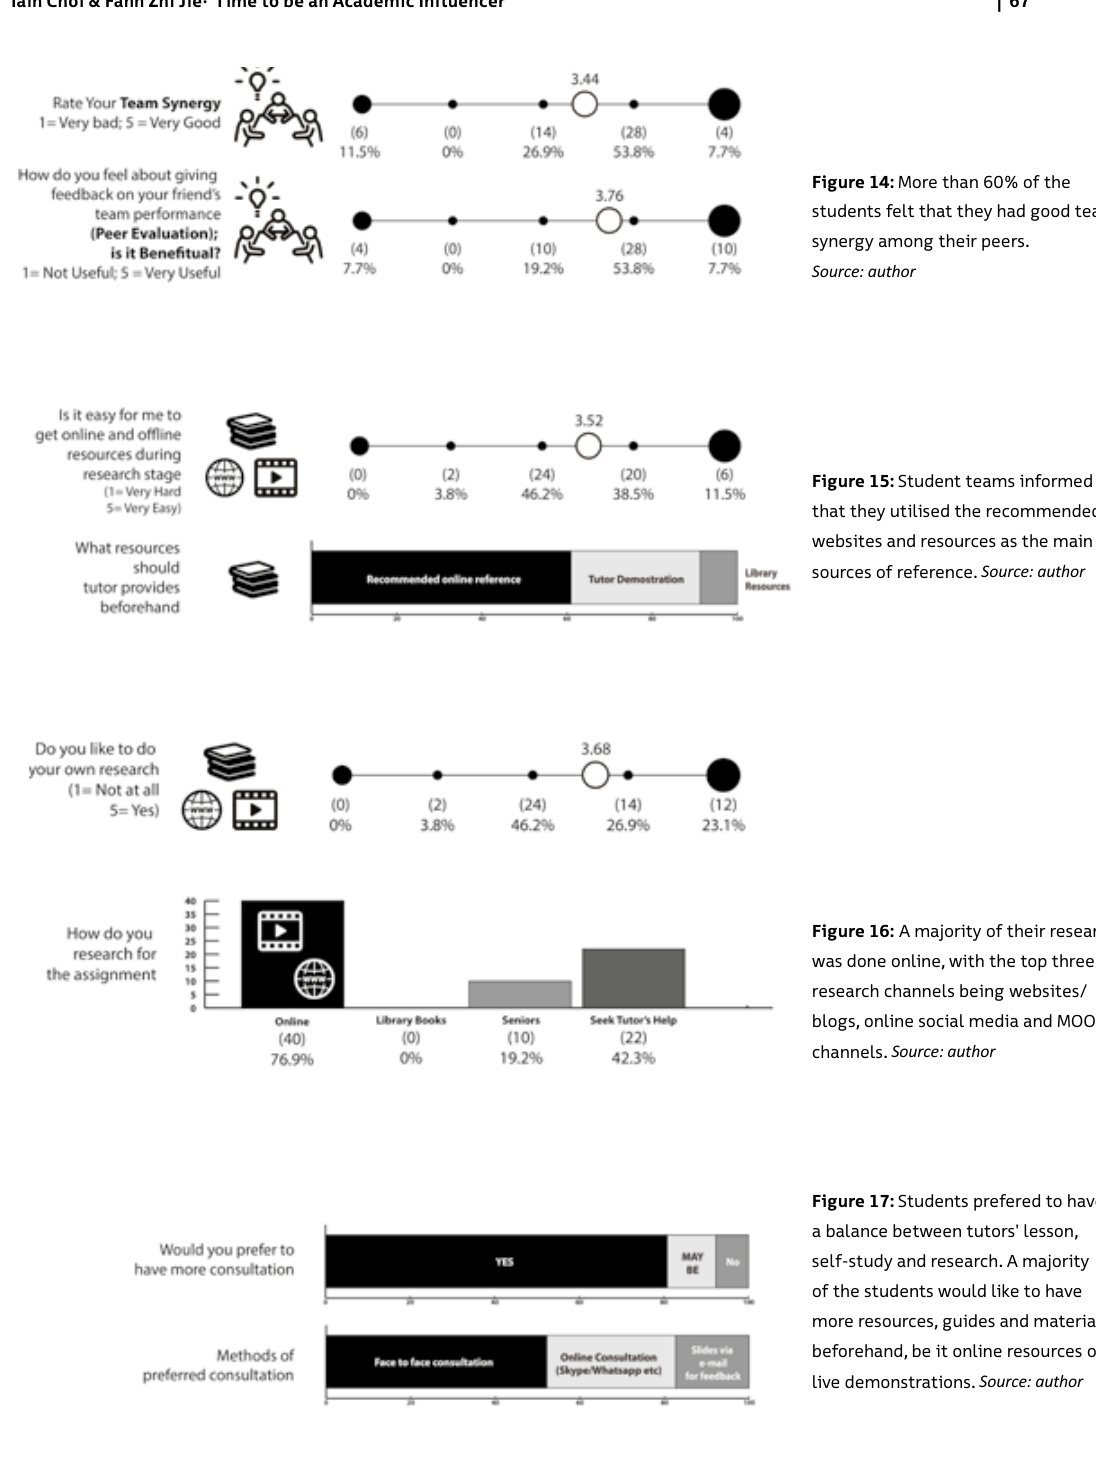
Figure 15: Student teams informed us